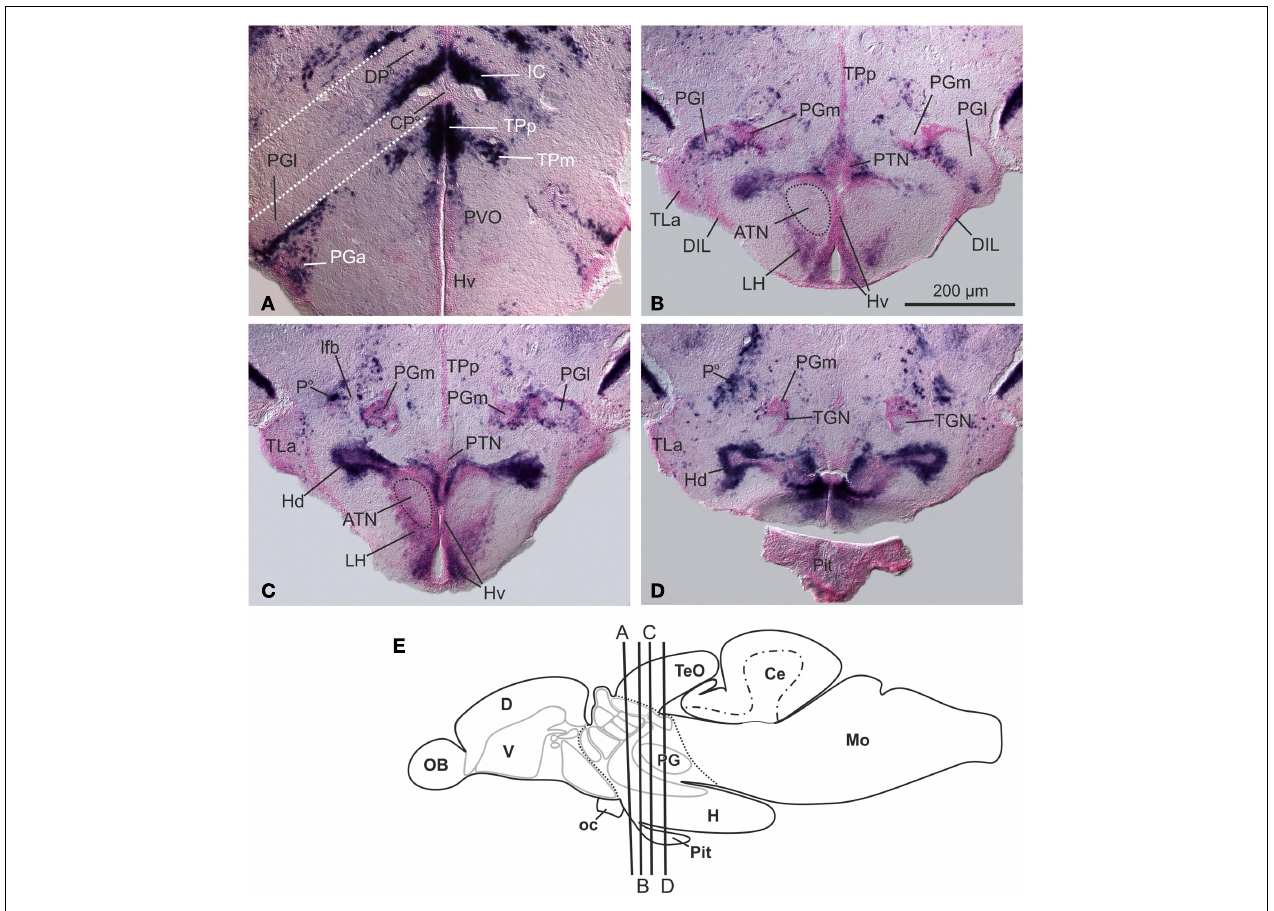
FIGURE 6 | Distribution of GAD67 -mRNA at the level of the preglomerular complex and hypothalmus (A–D). Note that the anterior part of the lateral preglomerular nucleus [PGl in (A) ] lies in the radial domain of the centroposterior thalamic nucleus [CP o ; (A) is a magnification of Figure 4D ].The